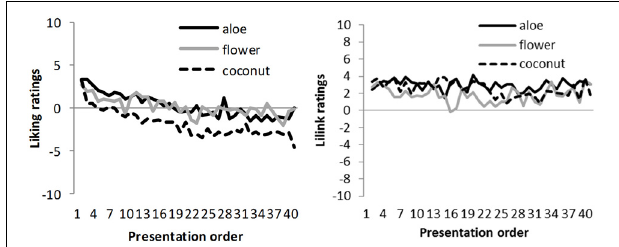
FIGURE 2 | Mean liking ratings of men (left) and women (right) across the number of